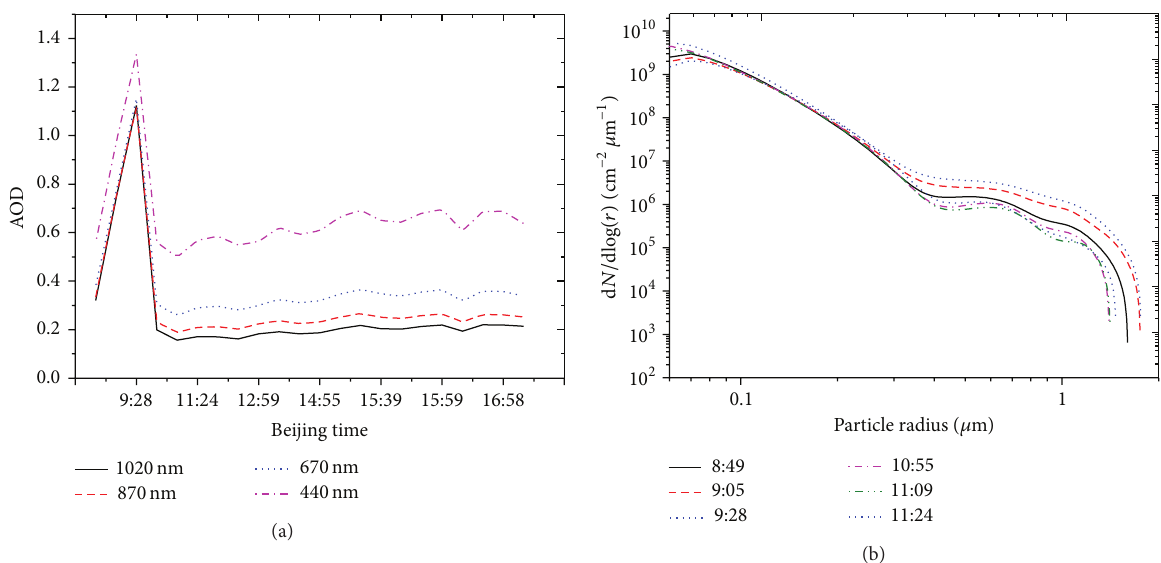
Figure 7: The AOD and size distribution of sand dust weather taken on November 1, 2012.